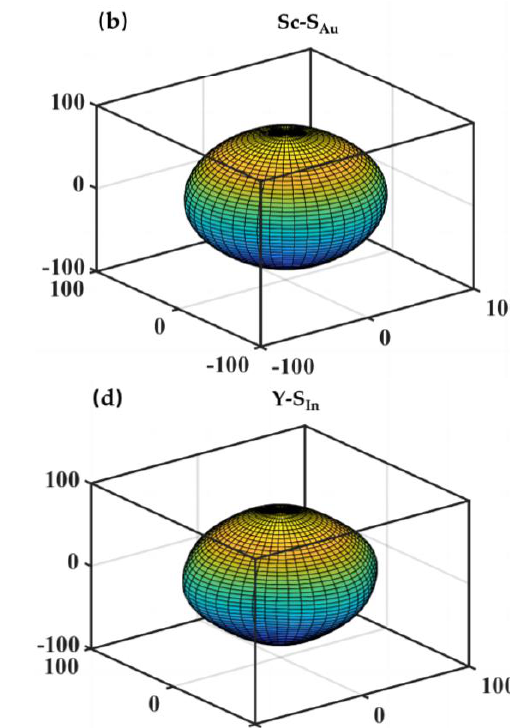
Figure 4. Three − dimensional surface structures of bulk modulus of AuIn 2 and RE doped systems. For all the graphs, the units are GPa.